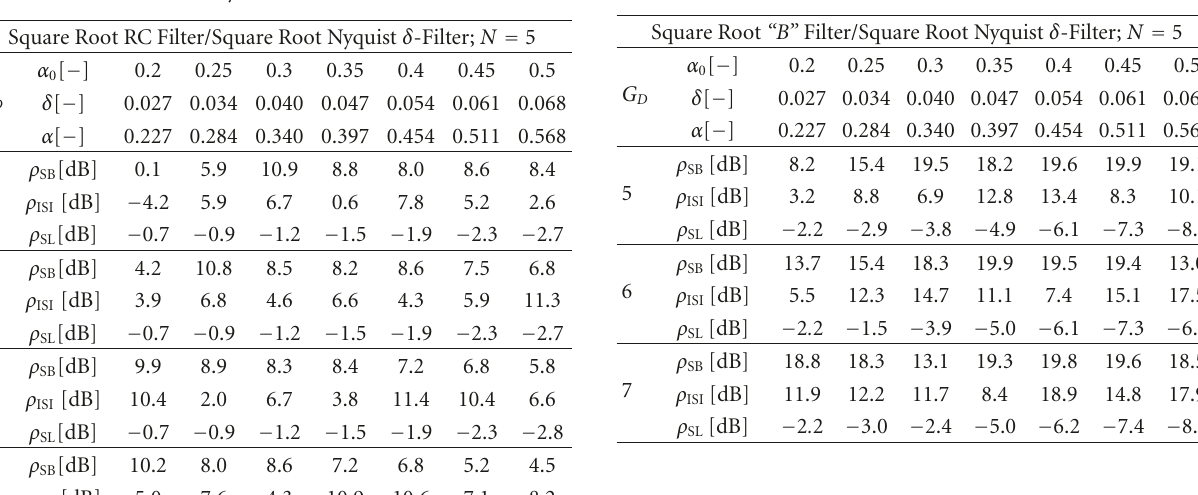
Table 3: Numerical values of ρ SB [dB], ρ ISI [dB], ρ SL [dB]. Square root “ B ” filter versus square root Nyquist δ -filter. The oversampling factor N = 5 is fixed and the group delay parameter G D of the filters